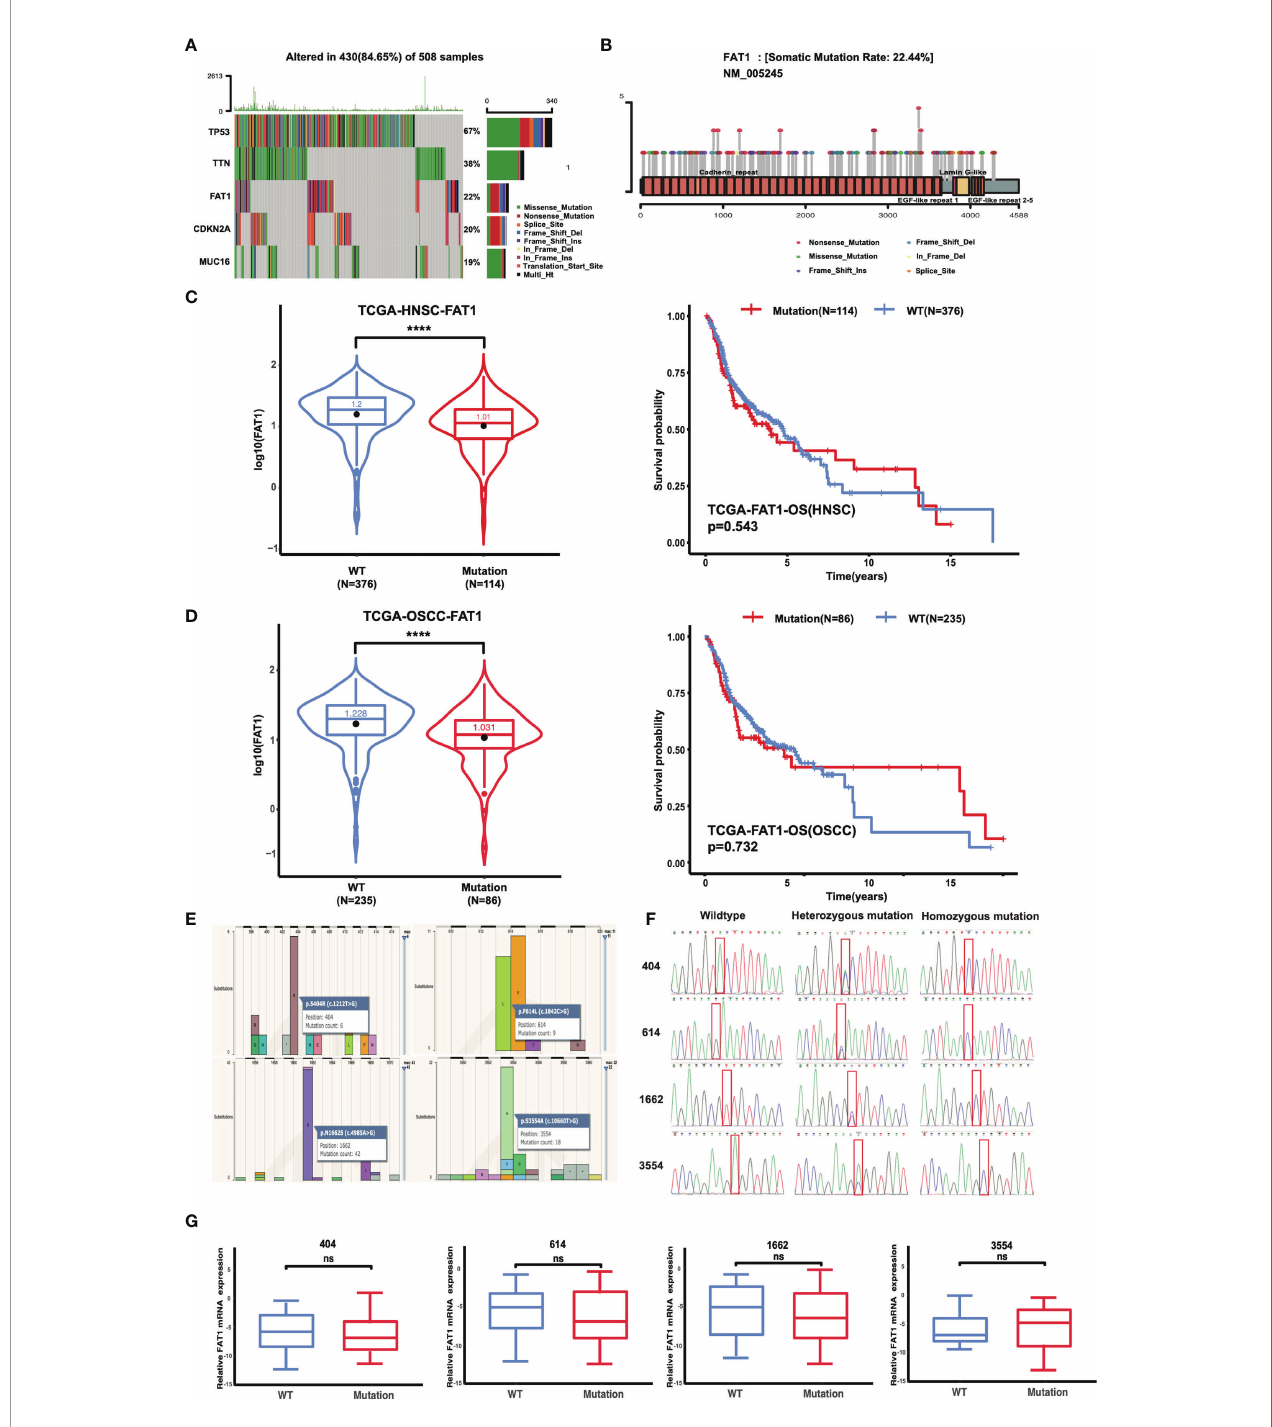
FIGURE 3 | FAT1 exhibits high genetic alterations in HNSC and FAT1 mutation status and the affection of the FAT1 expression. (A) FAT1 was a highly mutated gene (22%) in HNSC. (B) Frequency of FAT1 mutation sites in HNSC. (C) FAT1 mRNA expression status between FAT1 wild-type and FAT1 mutation tumor tissues in HNSC from TCGA (boxplot and violin plot); Kaplan – Meier survival curve of OS time between in HNSC FAT1 wild-type and FAT1 mutation tumor tissues from TCGA. (D) FAT1 mRNA expression status between FAT1 wild-type and FAT1 mutation tumor tissues in OSCC from TCGA (boxplot and violin plot); Kaplan – Meier survival curve of OS time between in OSCC FAT1 wild-type and FAT1 mutation tumor tissues from TCGA. (E) Four chosen sites of the FAT1 from all types of cancers in COSMIC online. (F) Representative image of Sanger con fi rmation of four variant sites. (G) Relative FAT1 mRNA expression status between FAT1 wild-type and FAT1 variants tumor tissues in clinical samples according to four variants sites (boxplot). ns, P > 0.05; ****P <